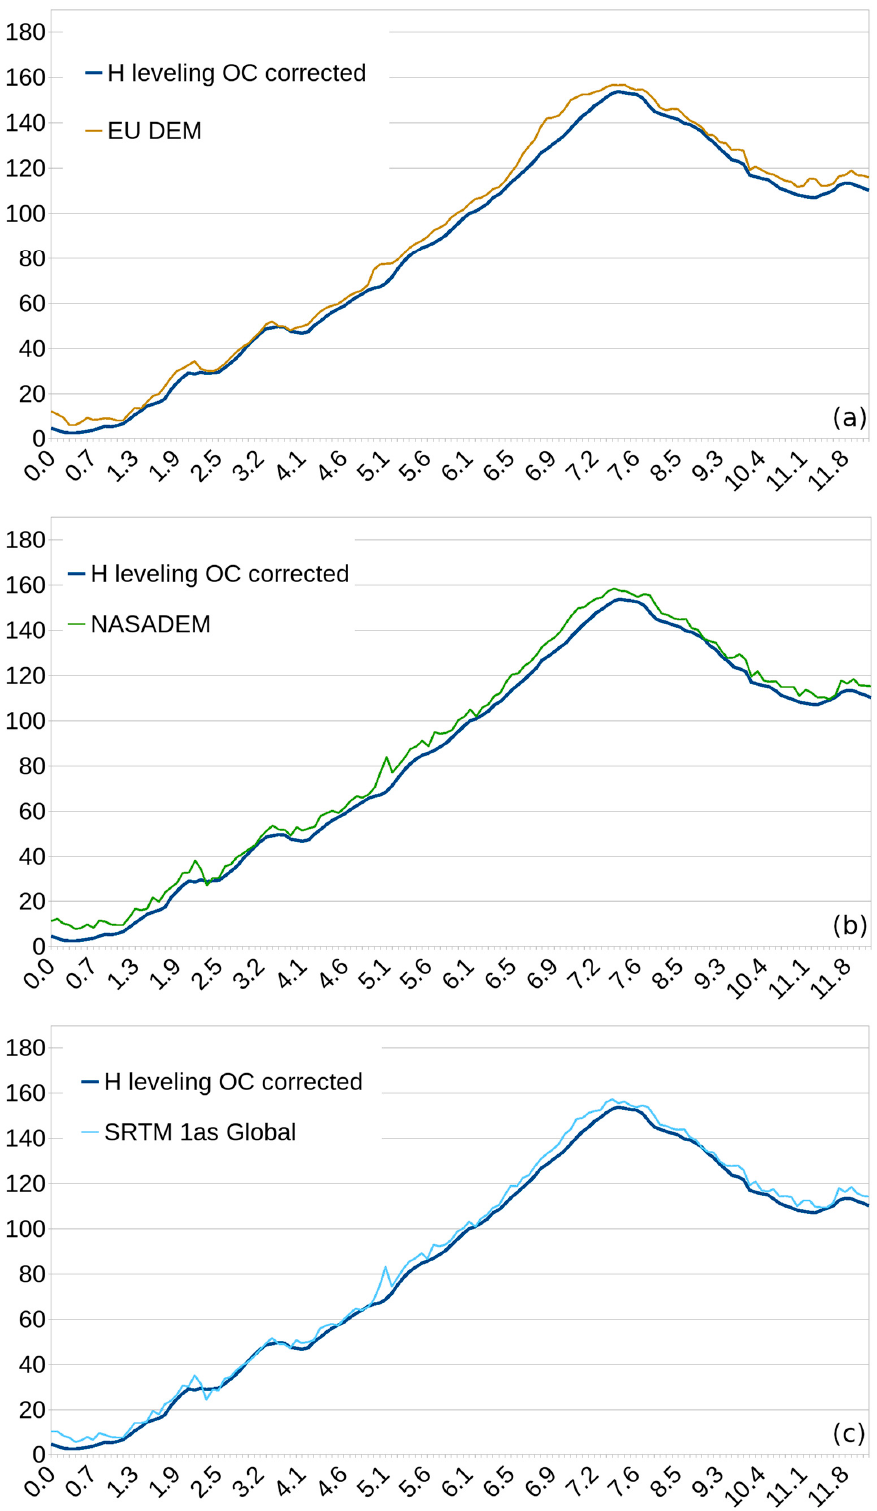
Figure 4. Height values along traverse in Central Greece from ( a ) EU DEM (dark orange line) and leveling, ( b ) NASADEM (green line) and leveling, and ( c ) SRTM Global (light blue line) and leveling. ( x ‐ axis: distance in km/ y ‐ axis: height in m).